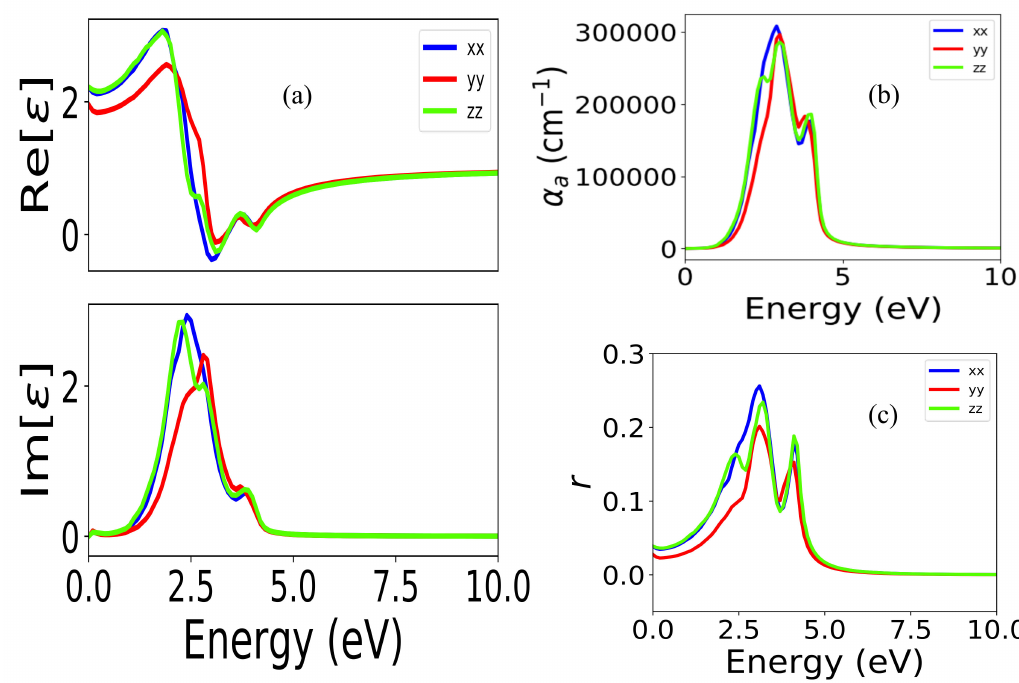
Figure 11. ( a ) Dielectric function, ( b ) absorption co-e ffi cient, and ( c ) reflectivity as a function of energy for the (Pb 0.593 Ca 0.406 ) TiO 3